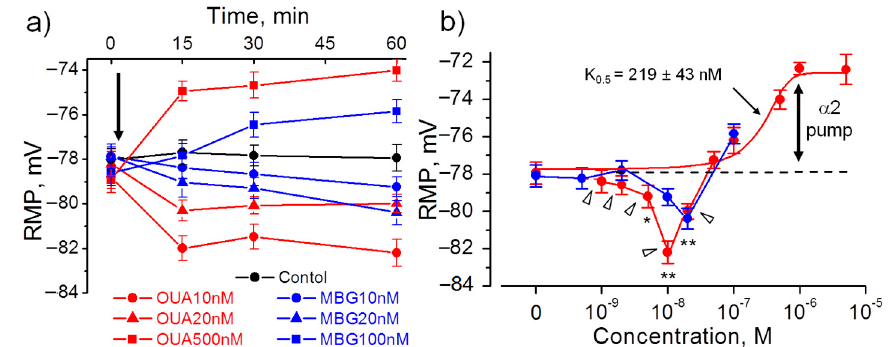
Figure 3. Acute hyperpolarizing and depolarizing e ff ects of ouabain (OUA, red) and marinobufagenin (MBG, blue) at the extrajunctional membrane of diaphragm muscles obtained from non-treated rats. ( a ) The RMP dynamics at di ff erent OUA or MBG concentrations (as indicated). First RMP recording was made prior to addition of OUA or MBG (indicated by arrow). ( b ) RMP values after 60 min incubation with di ff erent OUA or MBG concentrations. The solid curve is fitted with Hill equation and triangles indicate data points excluded from this fit; the calculated inhibitory constant K 0.5 for ouabain is indicated. Vertical arrow indicates the α 2 Na,K-ATPase electrogenic contribution to the RMP. Each data point represents the mean of measurements in at least 100 fibers from 4–6 muscles. * p < 0.05 and ** p < 0.01 with the corresponding control (in the absence of ouabain or marinobufagenin).